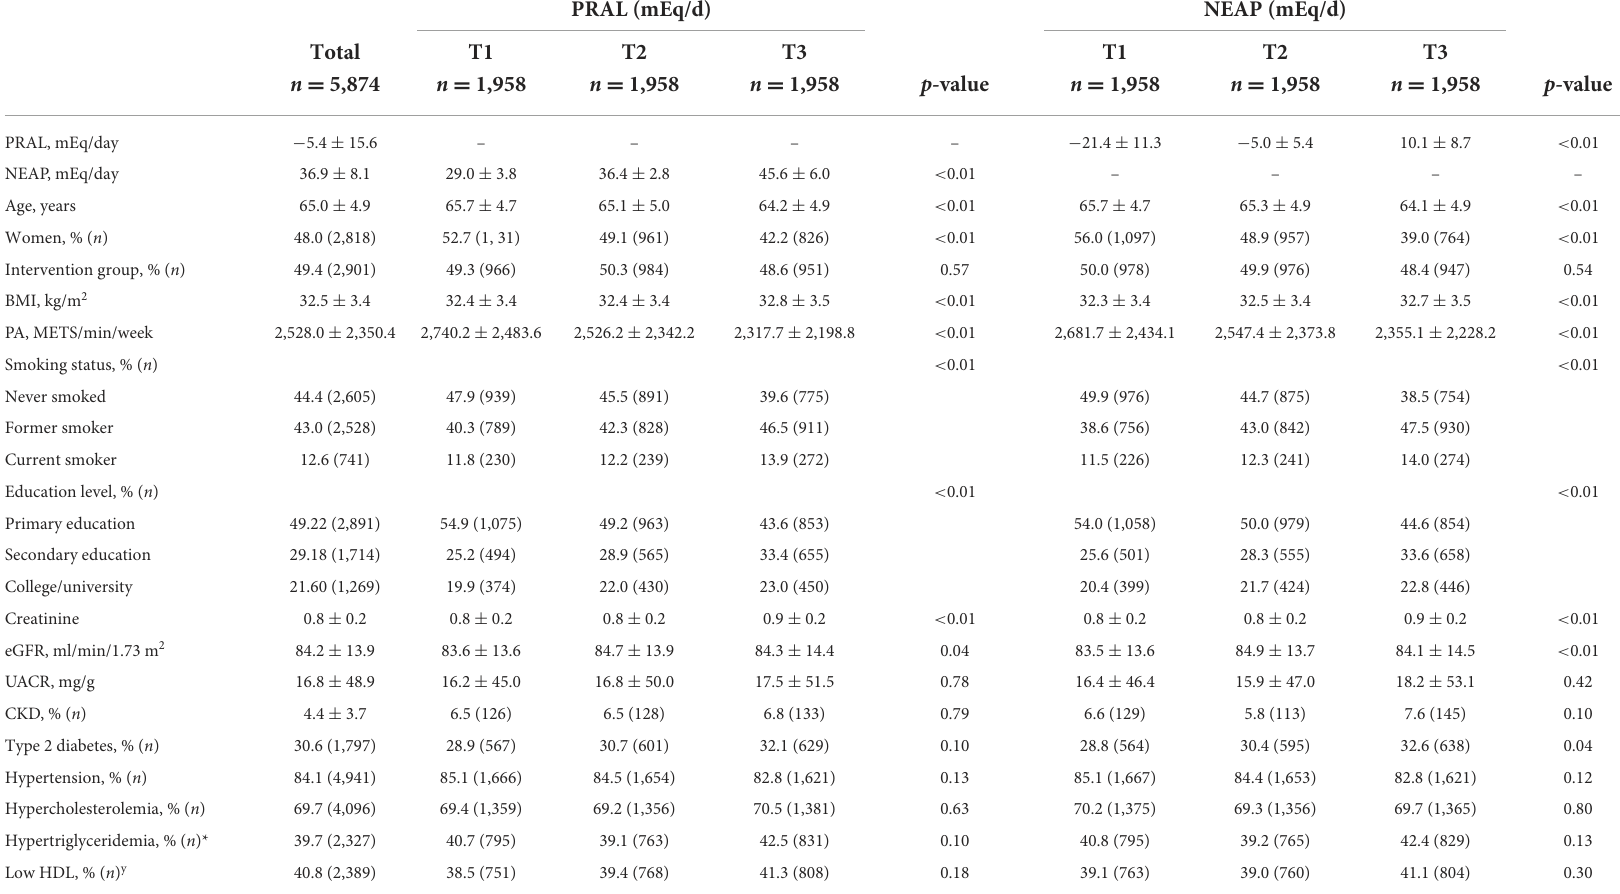
TABLE 1 Baseline characteristics of the study population with data on eGFR at 1-year follow-up by tertiles of PRAL and NEAP ( n = 5,874). PRAL (mEq/d) NEAP (mEq/d) Total